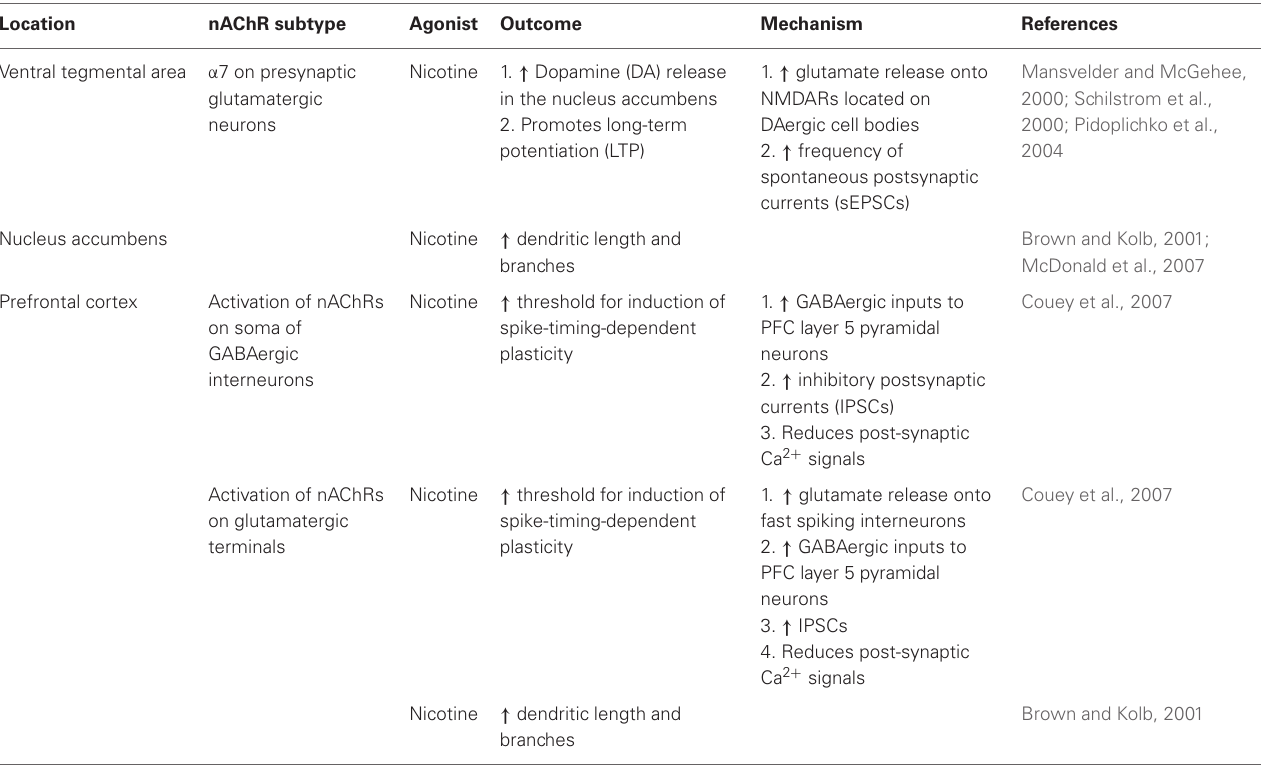
Table 1 | nAChRs modulate synaptic transmission in the mesolimbic